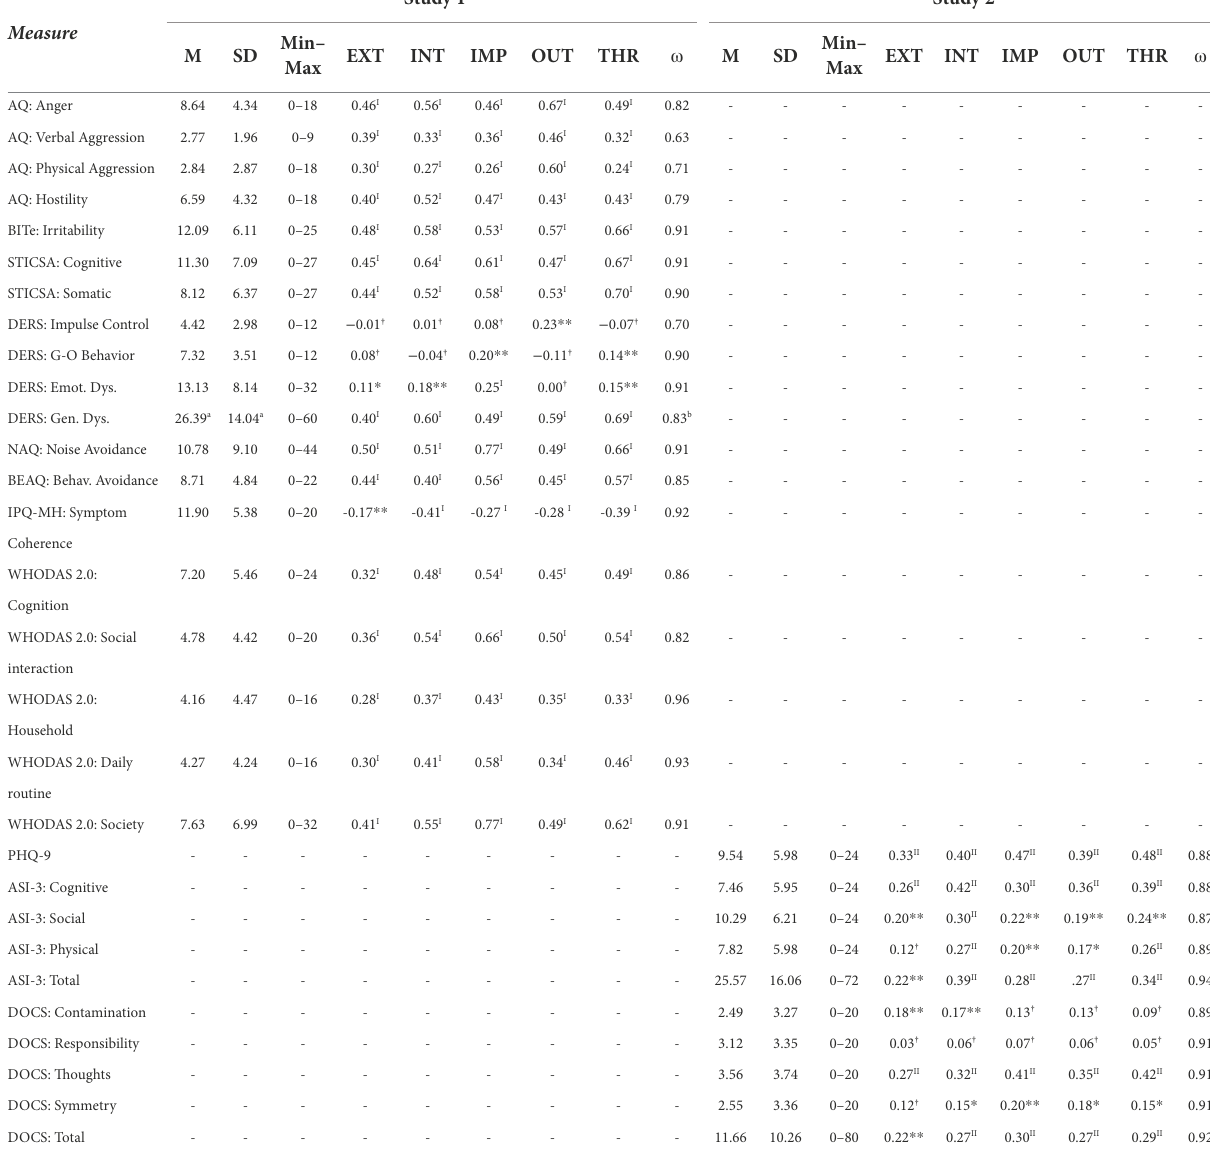
Table 5 Latent (Study 1) and Spearman’s (Study 2) intercorrelations of the S-Five with AQ, BITe, STICSA, DERS, NAQ, BEAQ, IPQ-MH, WHODAS 2.0, PHQ-9, ASI-3, and DOCS.